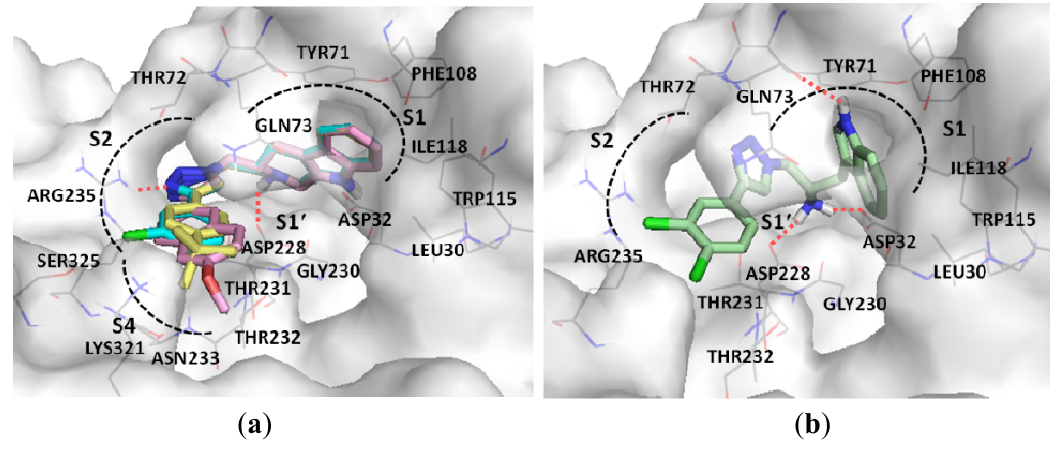
Figure 2. The binding modes of compounds with BACE1 enzyme; ( a ) tryptoline 6a (yellow), 6b (pink) and 6c (cyan); ( b ) tryptamine 12c (green).